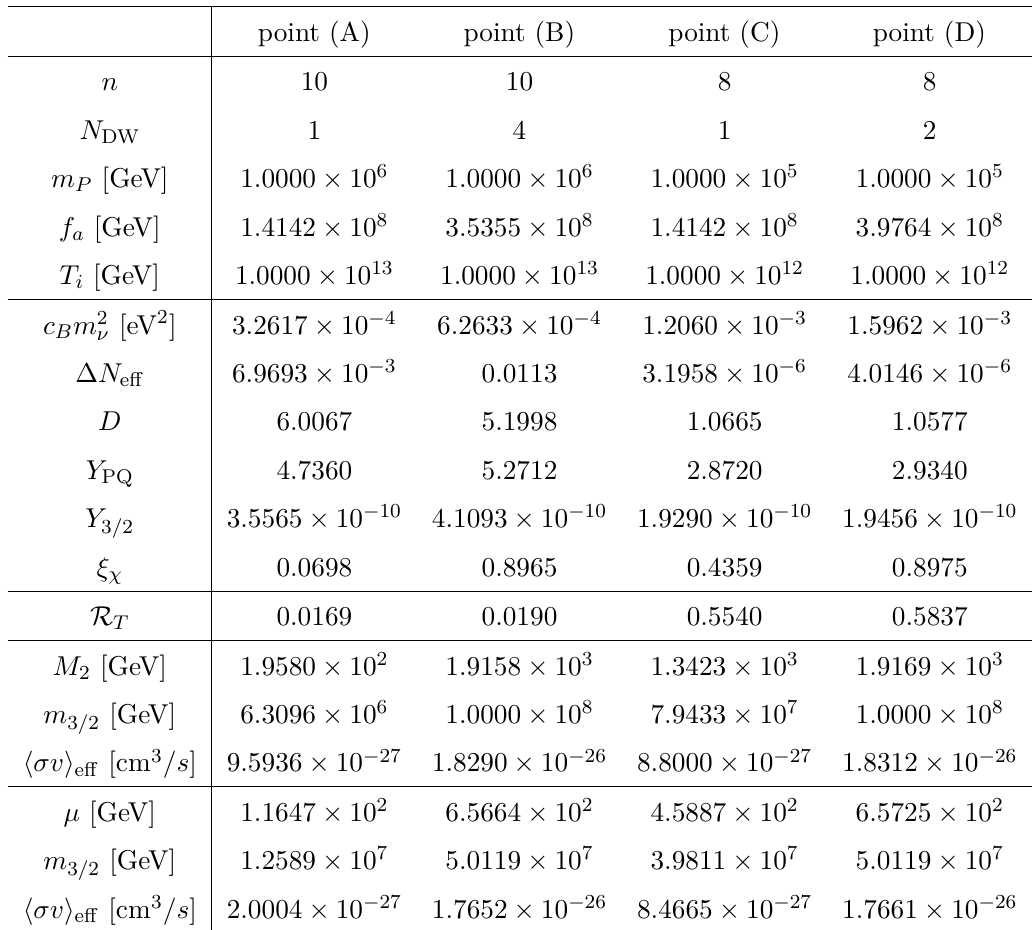
Table 1 . Values of various quantities at the benchmark points. In the last six rows in this table the LSP is assumed to be the wino (the line starting with M µ ) and the values of the LSP mass, the gravitino mass and the effective cross sections are shown for the correct dark matter